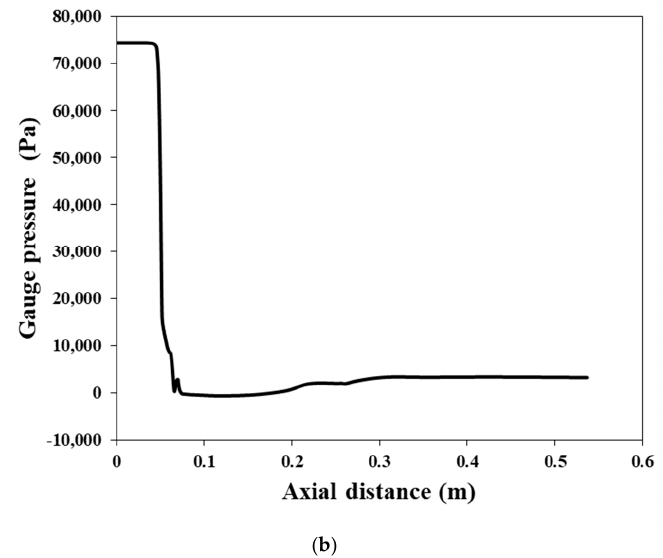
Figure 11. ( a ) The contour of volume fraction of the air in the ejector. ( b ) The plot of static pressure profile of ejector (along the center line of the ejector).